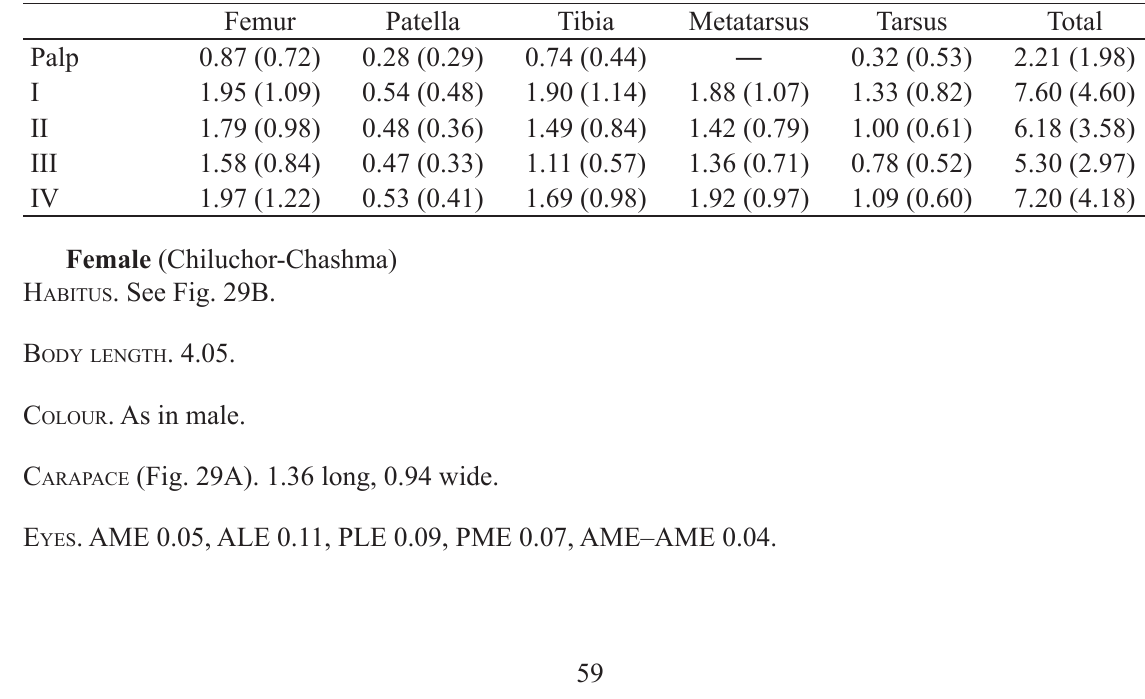
median line and margins of carapace light brown, as well as a weak and diffuse dorsal abdominal pattern consisting of interrupted median line anteriorly and a few transverse fasciae